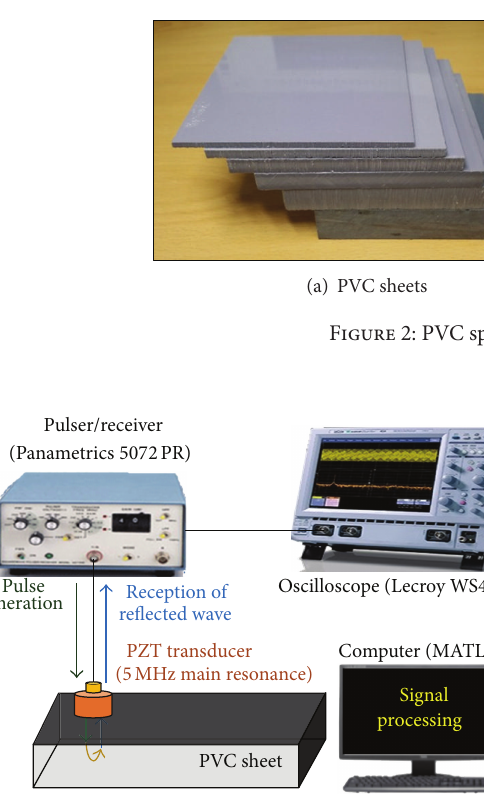
Figure 3: Pulse-echo ultrasonic inspection for PVC sheets.